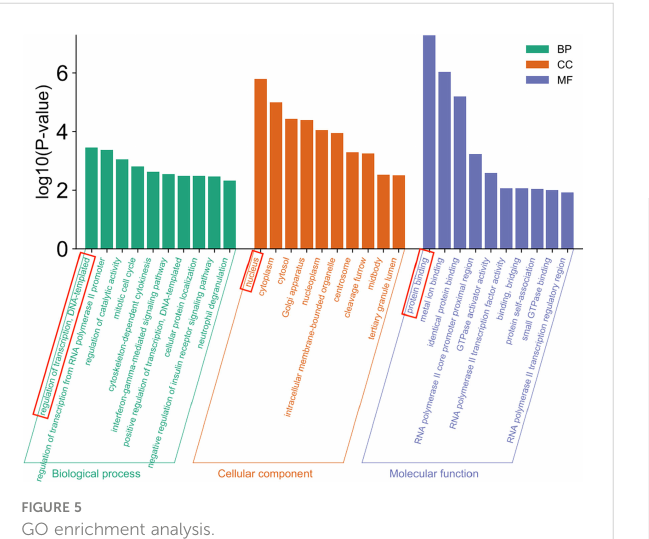
FIGURE 6 KEGG pathway enrichment